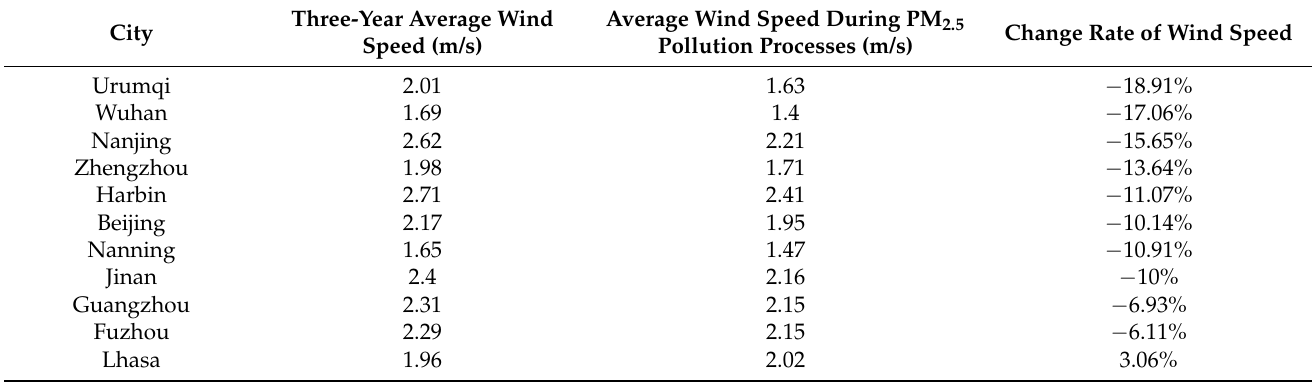
Table 2. The three-year average wind speed, the average wind speed during PM 2.5 pollution processes, and its change rate in the 11 cities.